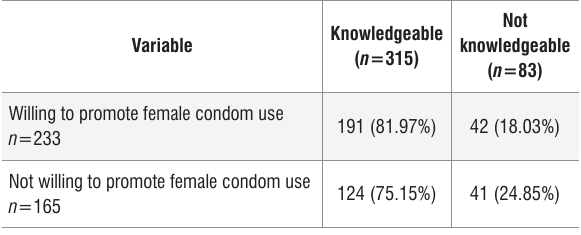
Not Knowledgeable knowledgeable ( n =315) ( n